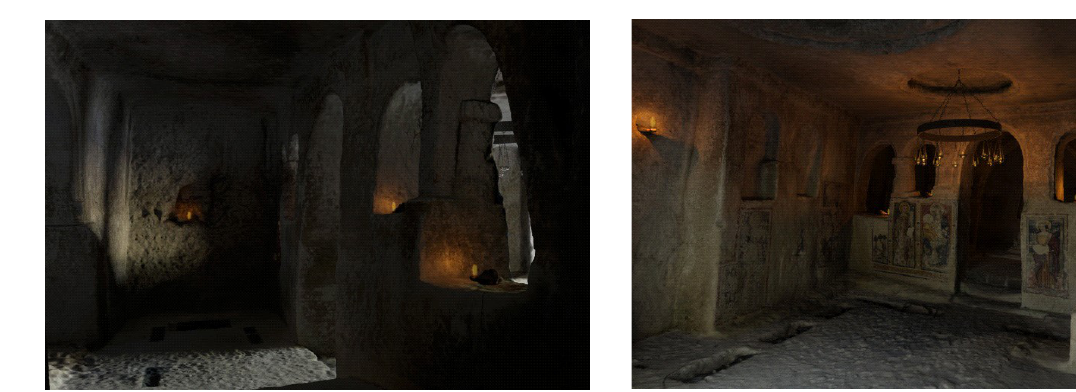
Figure 16: 3D Studio Max Sw. Photorealistic render of the bema with combined lighting. h17.00 p.m.-Date: 21 Dec.2018